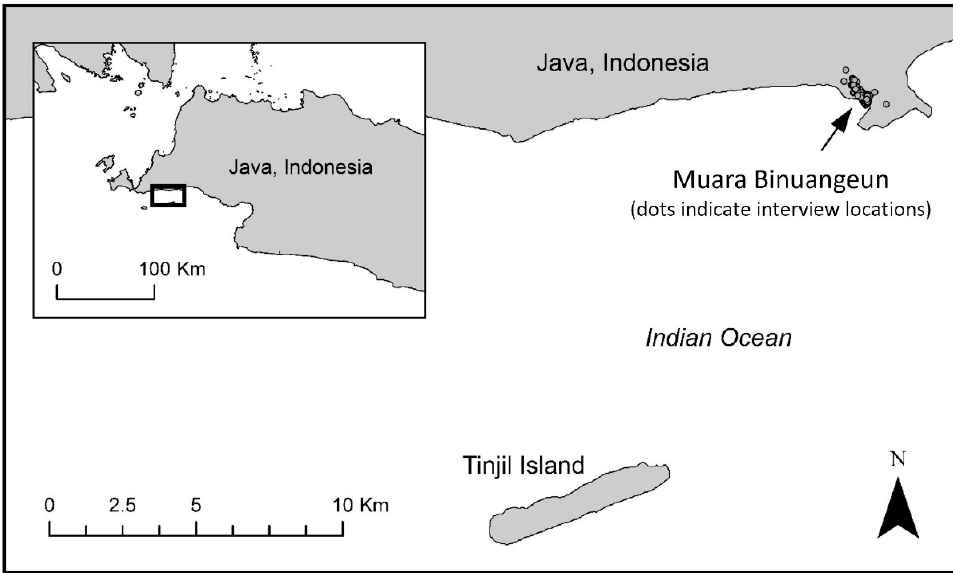
Figure 1. Map of the study area in Banten, Indonesia, including Tinjil Island, the village area of Muara Binuangeun, and locations where surveys were administered as individual in-person interviews. Inset shows the larger view, with a rectangle indicating the area of detail.